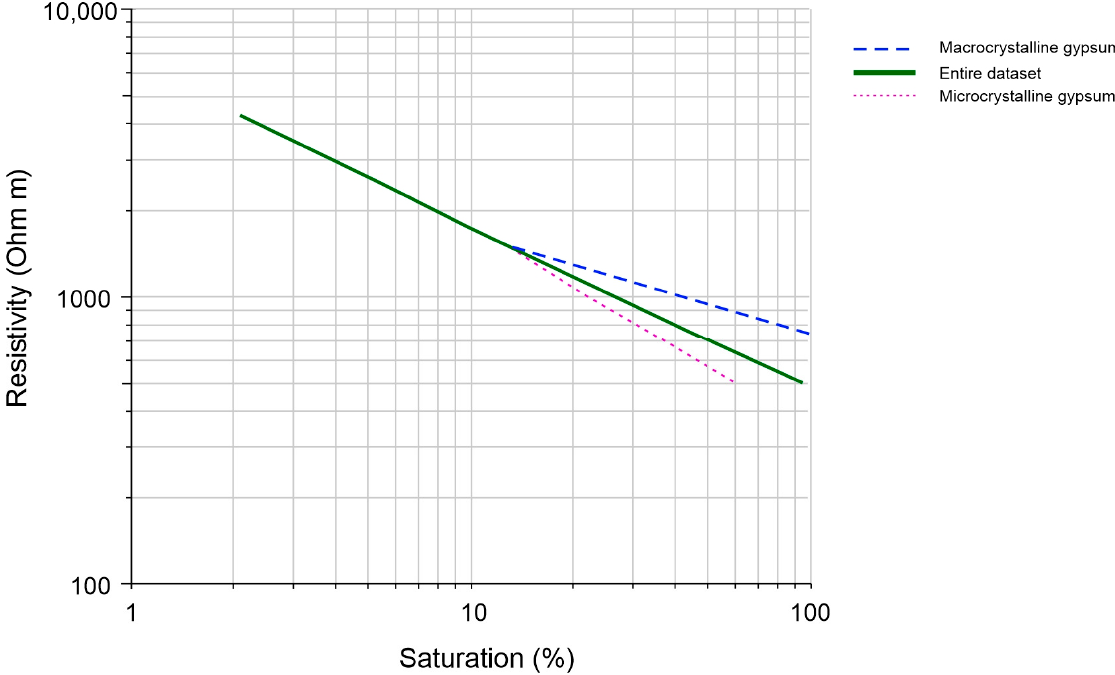
Figure 17. Resistivity data as a function of the saturation conditions from measures on samples with different saturation degrees (modified from Caselle et al., 2019 [14]).